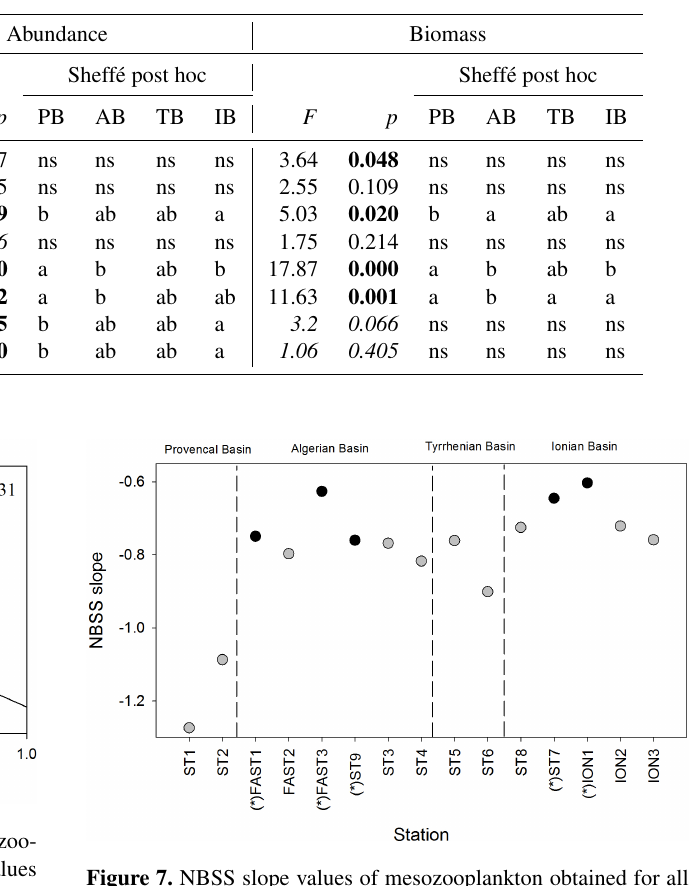
Figure 7. NBSS slope values of mesozooplankton obtained for all stations during the PEACETIME survey. Black dots represent night samples, and gray dots represent day